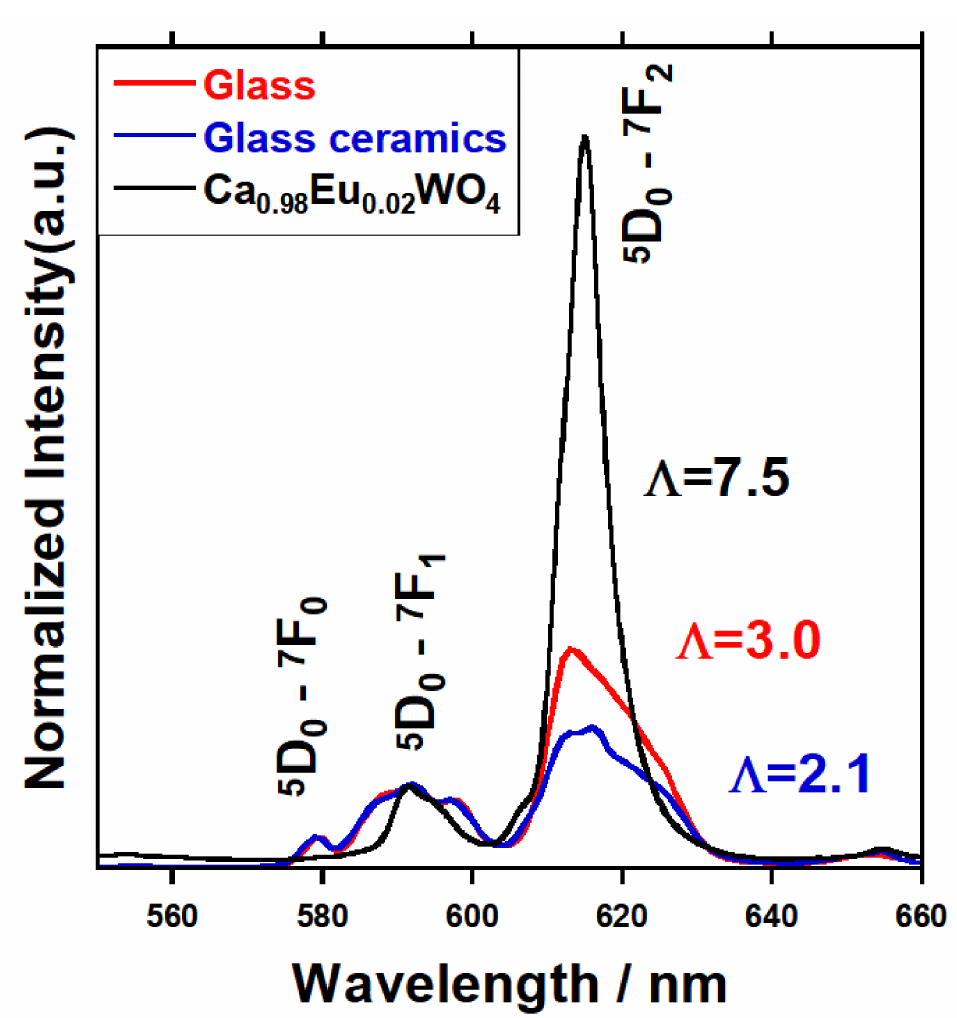
Figure 8. PL spectra and asymmetry ratio ( ∧ ) of 15mol% Ca 2.98 Eu 0.02 WO 6 samples (pristine glass and glass-ceramic) and Ca 0.98 Eu 0.02 WO 4 crystal, normalized by the 593 nm PL